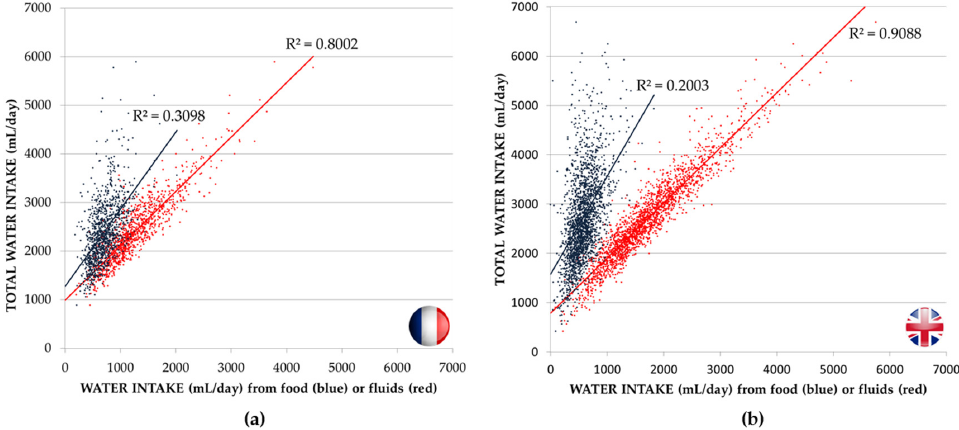
Figure 1. Volume and contribution to total water intake of water from fluid and food moisture in the male adult sample of the French 2013 survey called Enquête Comportements et Consommations Alimentaires en France (CCAF) ( a , b ) and the UK surveys called National Diet and Nutrition Survey (NDNS) 2008/2009–2011/2012 ( c , d ).